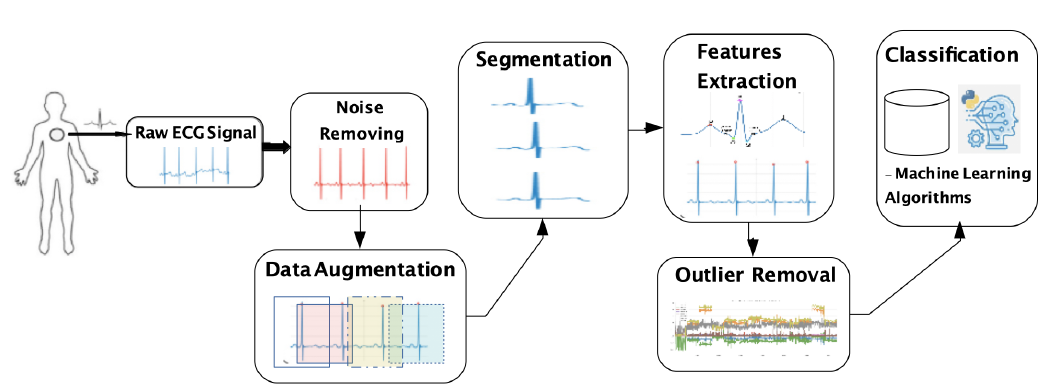
Figure 1. Overview of all processing steps of